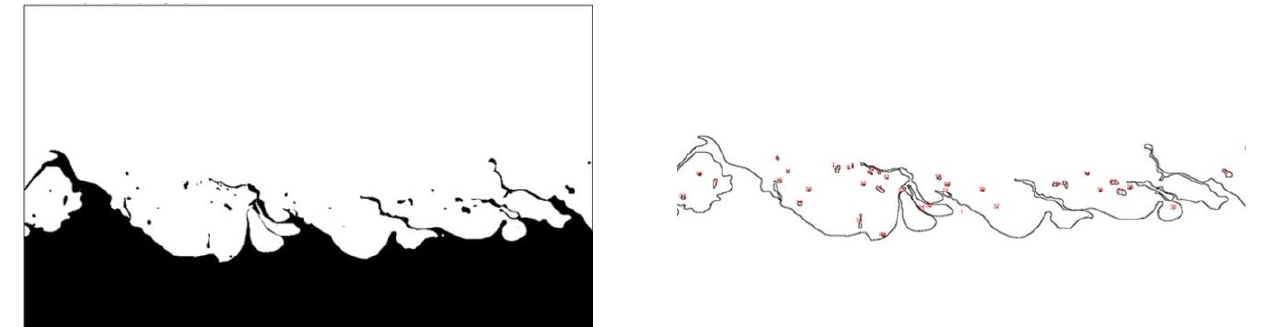
Figure 10. Particles produced by Kelvin–Helmholtz instability: volume fraction contour ( left ), melt-water interface outline ( right ).